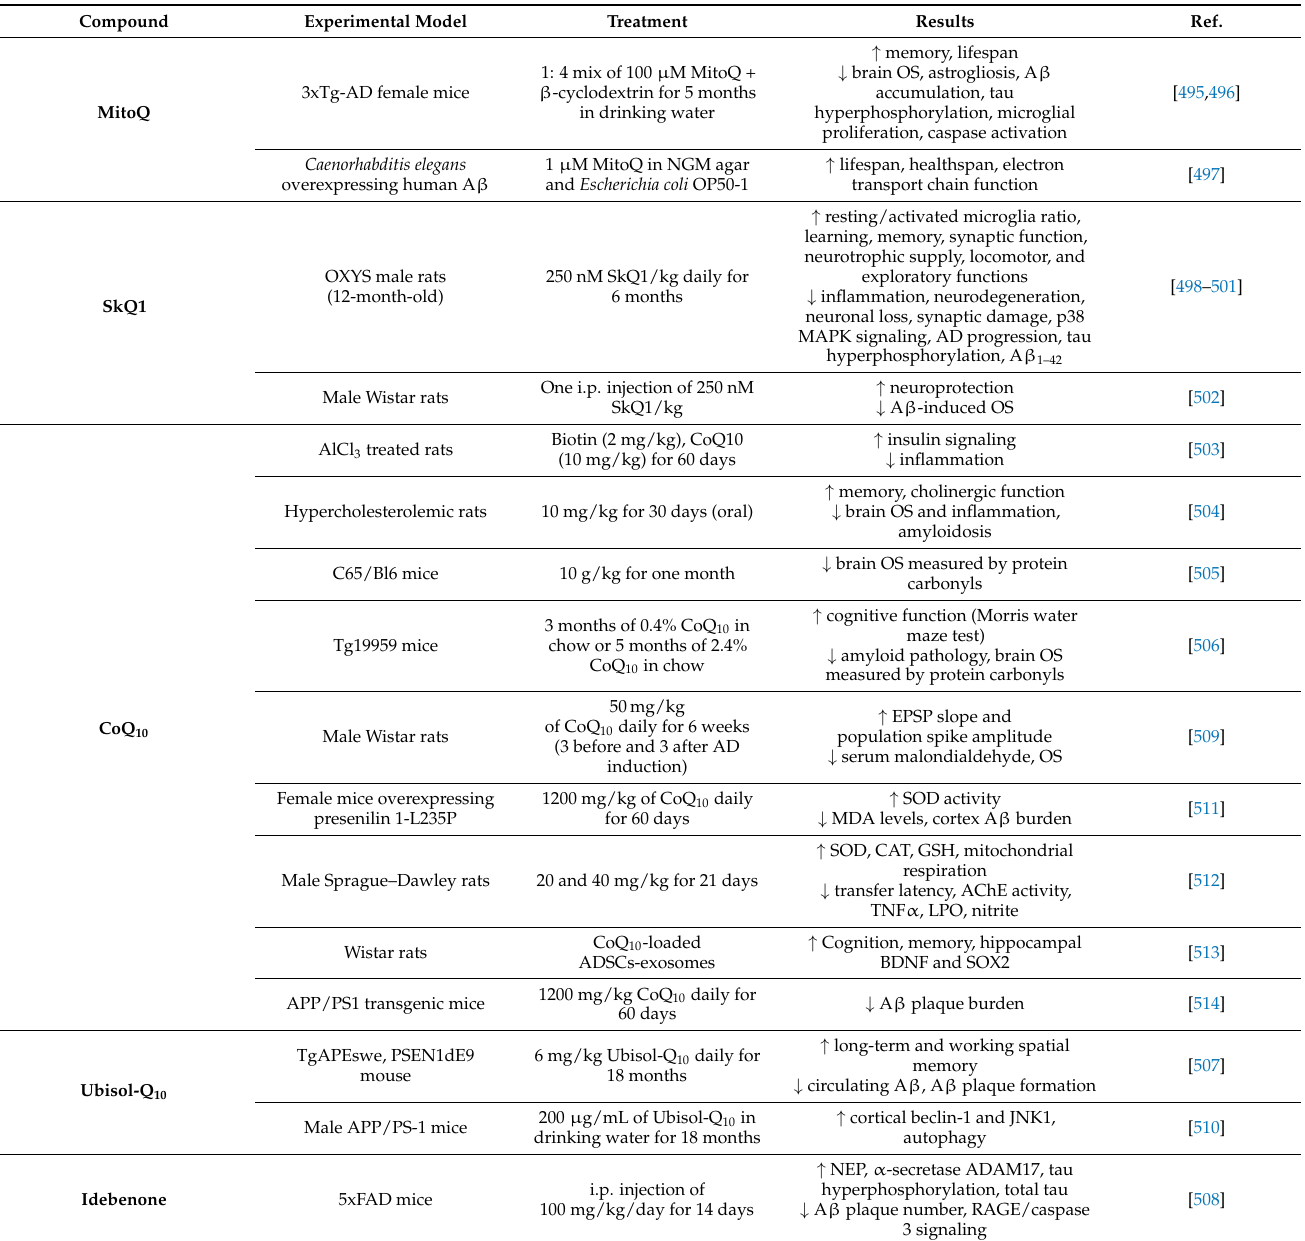
Table 2. Preclinical and clinical studies on mitochondria-targeted compounds in AD. Compound Experimental Model Treatment Results